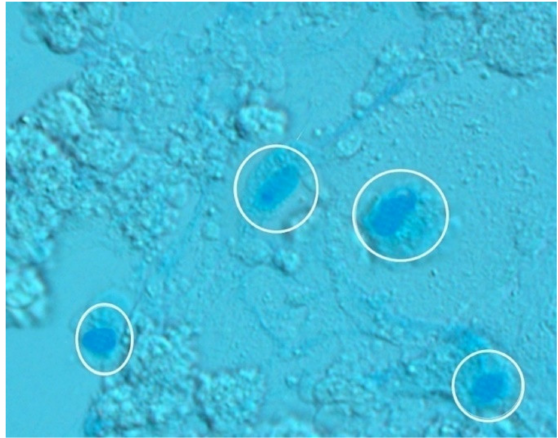
Figure 9. Fluorescence microscopic image of the cytotoxic